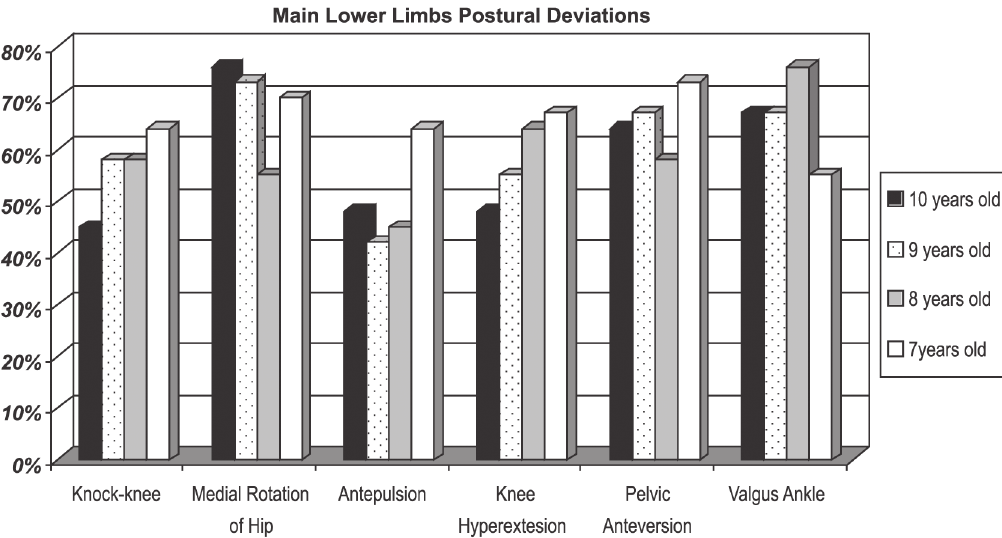
Figure 1 - Comparison among the main postural deviations of the lower